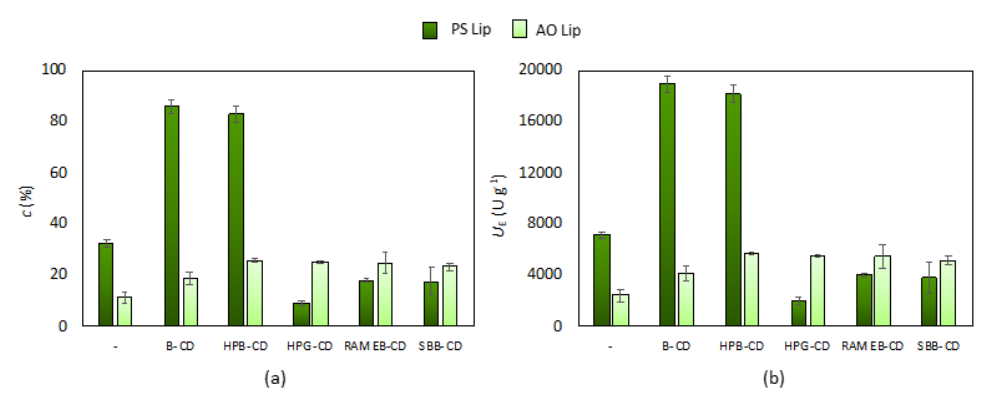
Figure 2. Effect of cyclodextrins (B-CD: β-cyclodextrin, HPB-CD: 2-hydroxypropyl-β-cyclodextrin, HPG-CD: 2-hydroxypropyl-γ-cyclodextrin, RAMEB-CD: randomly methylated β-cyclodextrin, SBB-CD: sulfobutylated-β-cyclodextrin) on ( a ) the conversion (c, %) of p -NPP hydrolysis catalyzed by lipase from Burkholderia cepacia (PS Lip, in dark green) and from Aspergillus oryzae (AO Lip, in light green) and on ( b ) the specific enzyme activity (U E , U × g −1 ) after 5 min at 37.0 °C in standard lipase assay (according to Section 2.2). Cyclodextrin:lipase ratios were 1:3 ( w / w ) for PS Lip and 1:1 ( w / w ) for AO Lip.